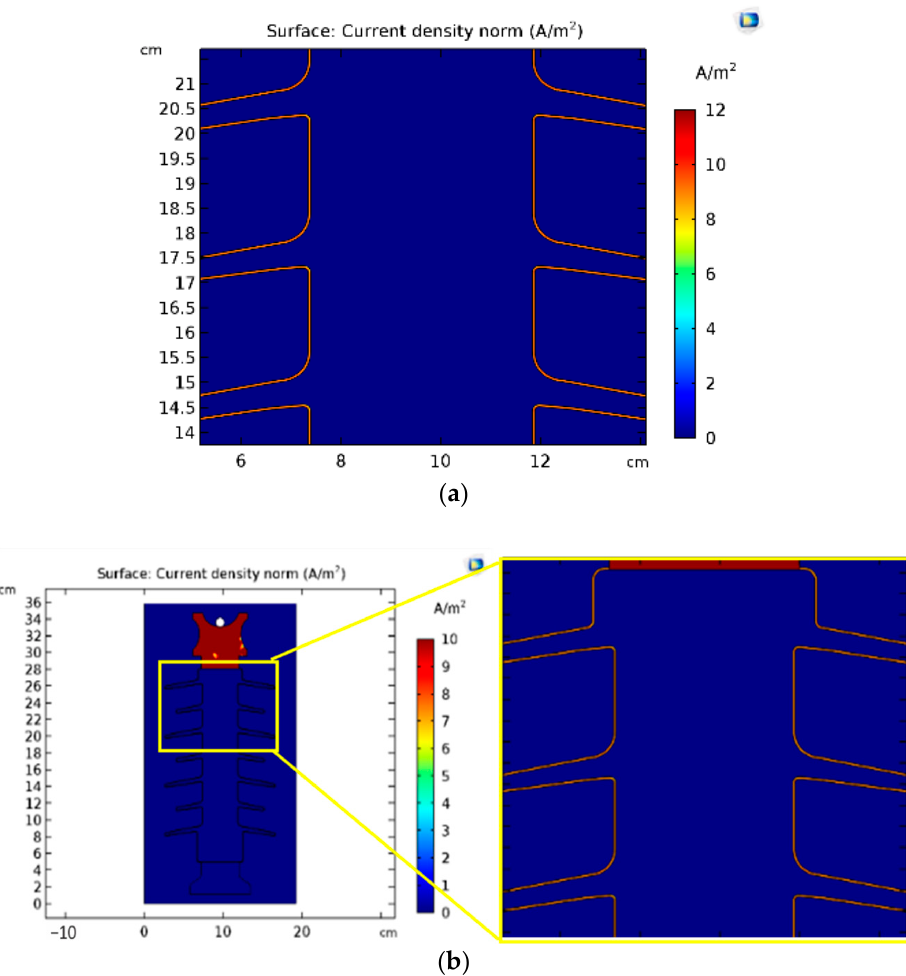
Figure 15. Current density of insulator with ( a ) salt contaminant with electrical conductivity of 3.46 × 10 − 4 S/m, and ( b ) fly ash contaminant with electrical conductivity of 2.81 × 10 − 4 S/m.